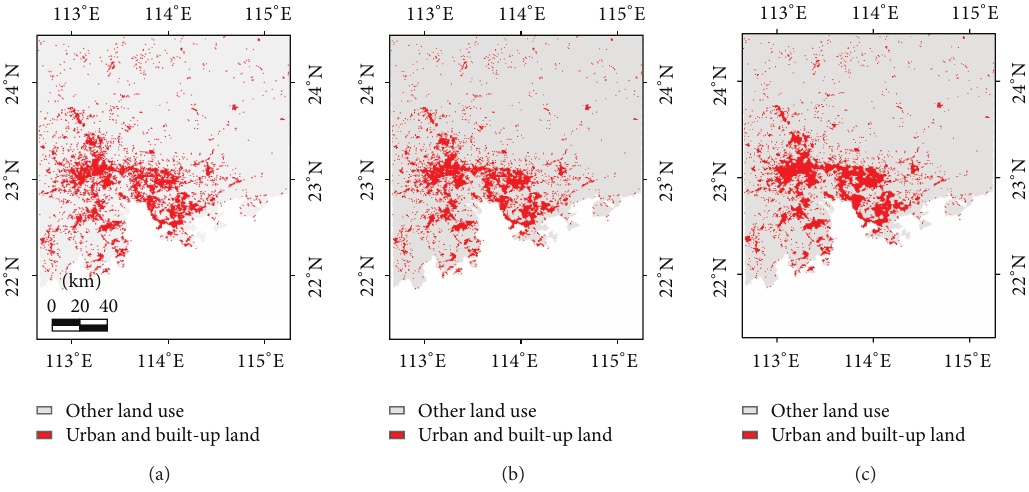
Figure 5: The simulation result of the urban expansion under the regional planning: (a) 2010, (b) 2015 and (c) 2020. Table 4: Comparison of nine urban meteorological stations observed (OBS) and model simulated (SIM) mean air temperature ( 𝑇 2 Celsius) and precipitation ( P , millimeters) of the year 2005 over the 16 observation